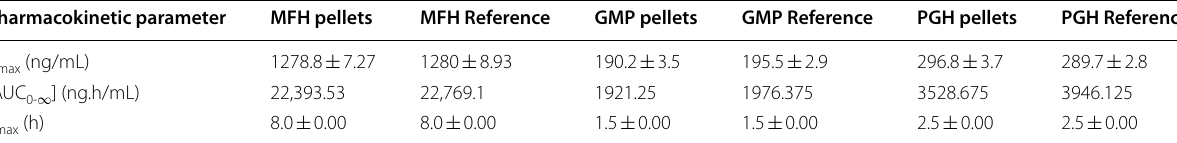
Values are mean